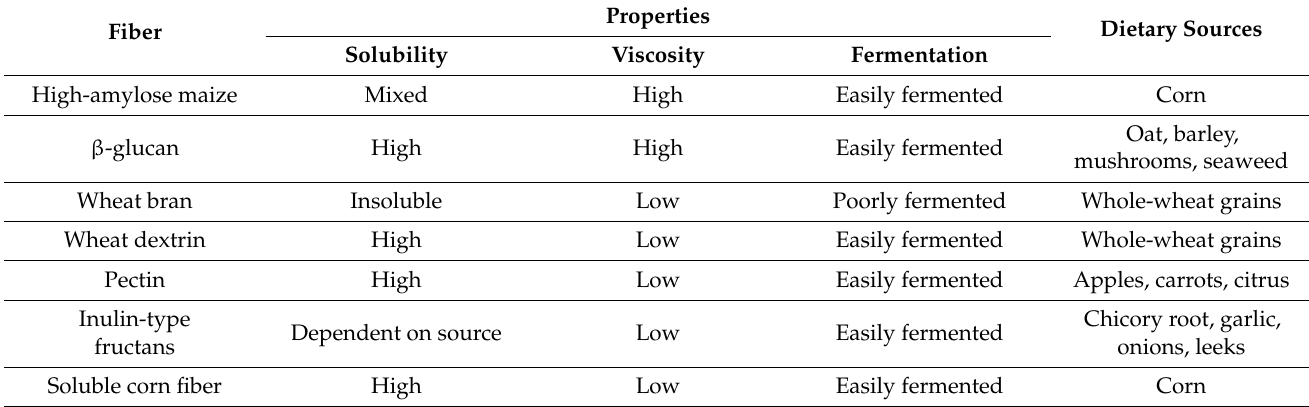
Table 1. Properties and dietary sources of each fiber